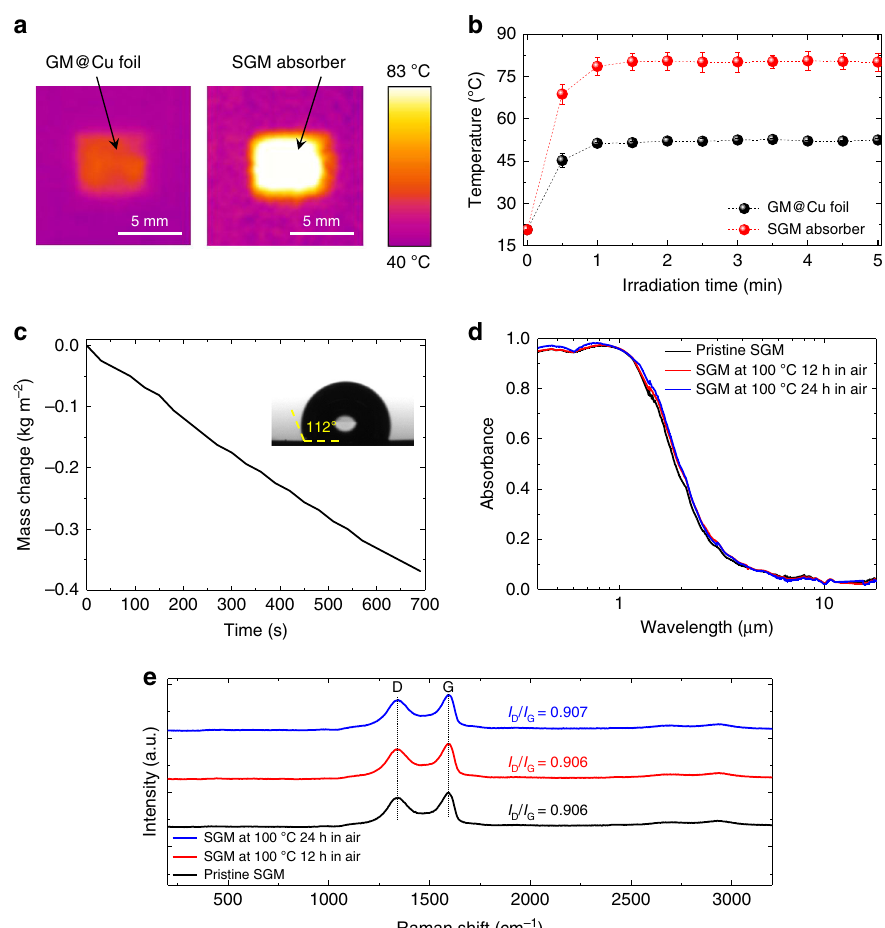
Fig. 5 Photothermal application and thermal stability of SGM absorbers. a Thermal images of the fl at GM@Cu foil and SGM absorber under sunlight illumination in an open environment. b Temperatures of the fl at GM@Cu foil (black) and SGM absorber (red) after various periods of illumination. Error bars on the Y -axis show standard deviations calculated from the measured temperatures. c Mass change of water with SGM absorber as function of time under one sun illumination. Inset: surface wetting property of SGM absorber. d , e Measured d absorbance spectra and e Raman spectra of SGM absorbers before, after 12 h, and after 24 h of heating at 100 °C in